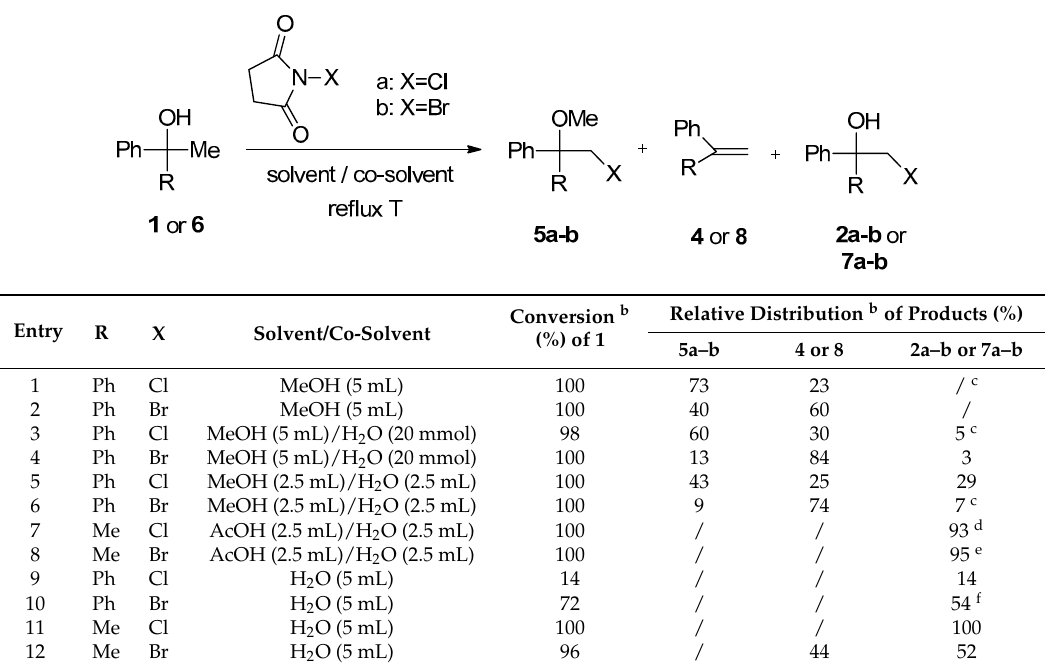
Molecules 2016 , 21 , 1325 Table 2. Transformation of 1,1-diphenylethanol ( 1 ) or 2-phenyl-2-propanol ( 6 ) with NCS and NBS in methanol, acetic acid, aqueous media and their mixtures a .